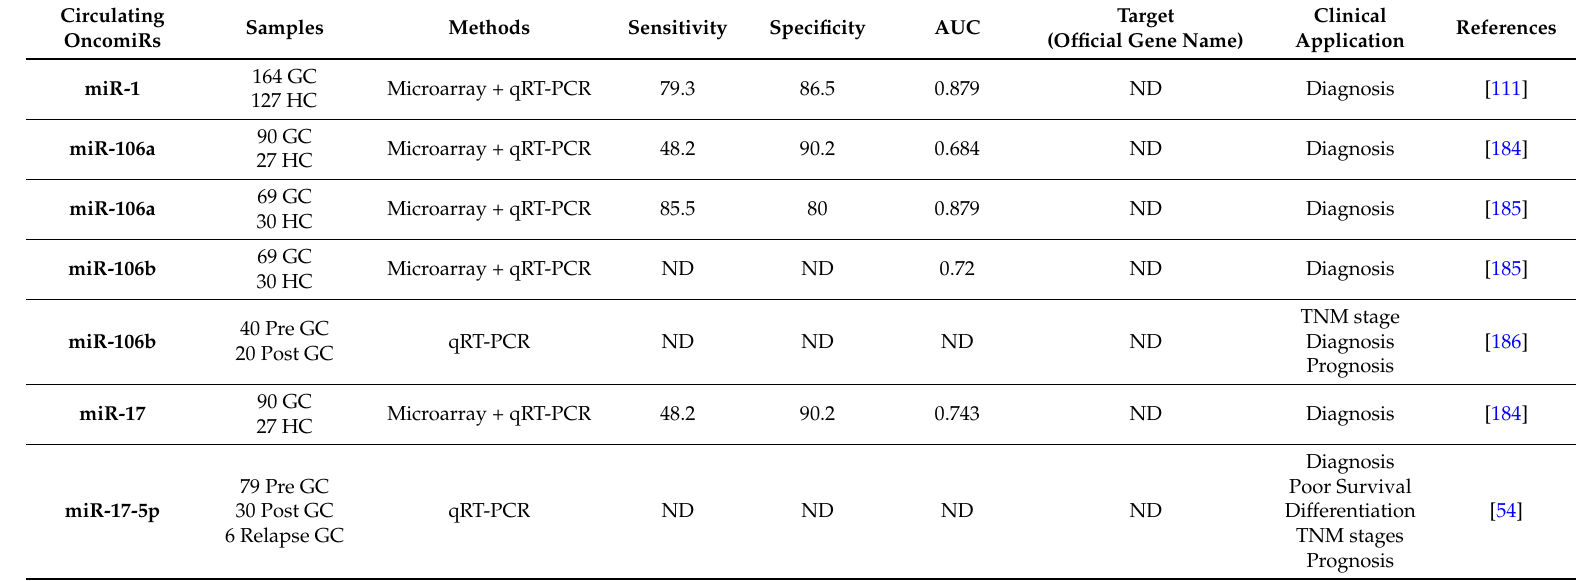
Table 3. Up-regulated circulating miRNAs for